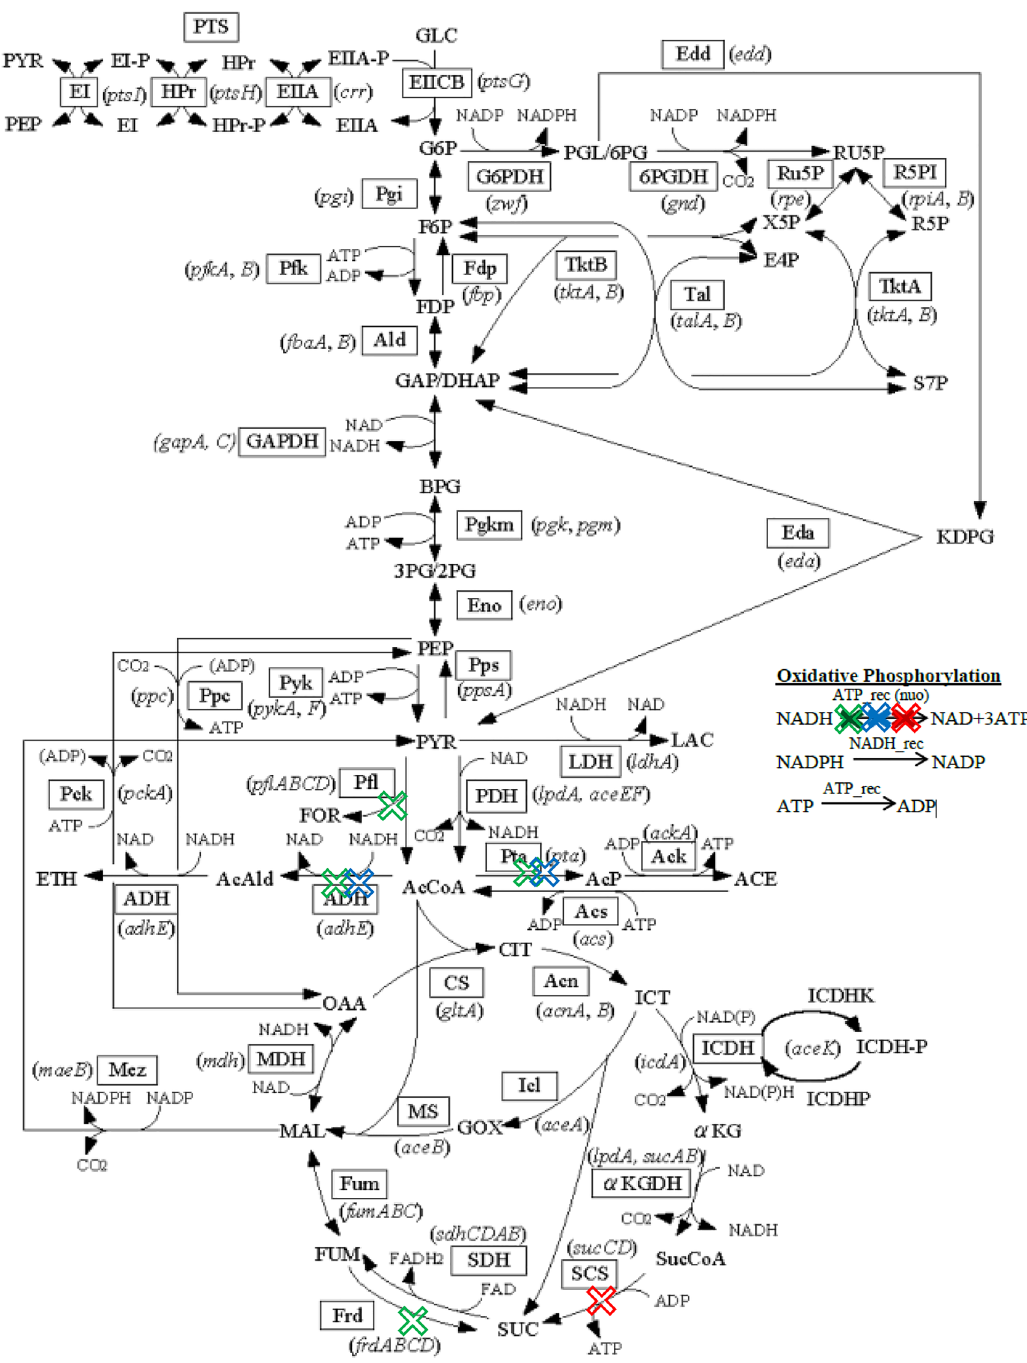
Figure 5: Metabolic pathway of Escherichia coli for lactate. The crosses with red, blue, and green color respectively denote the first, second, and third set of gene knockout list